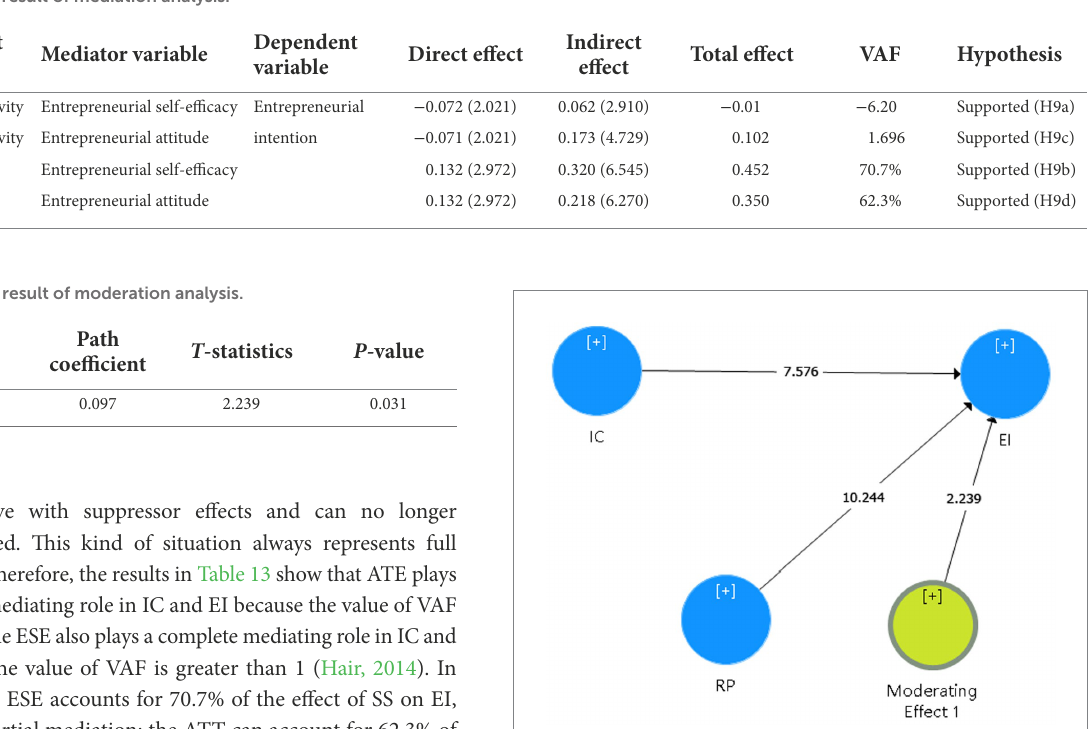
TABLE 13 The result of mediation analysis.